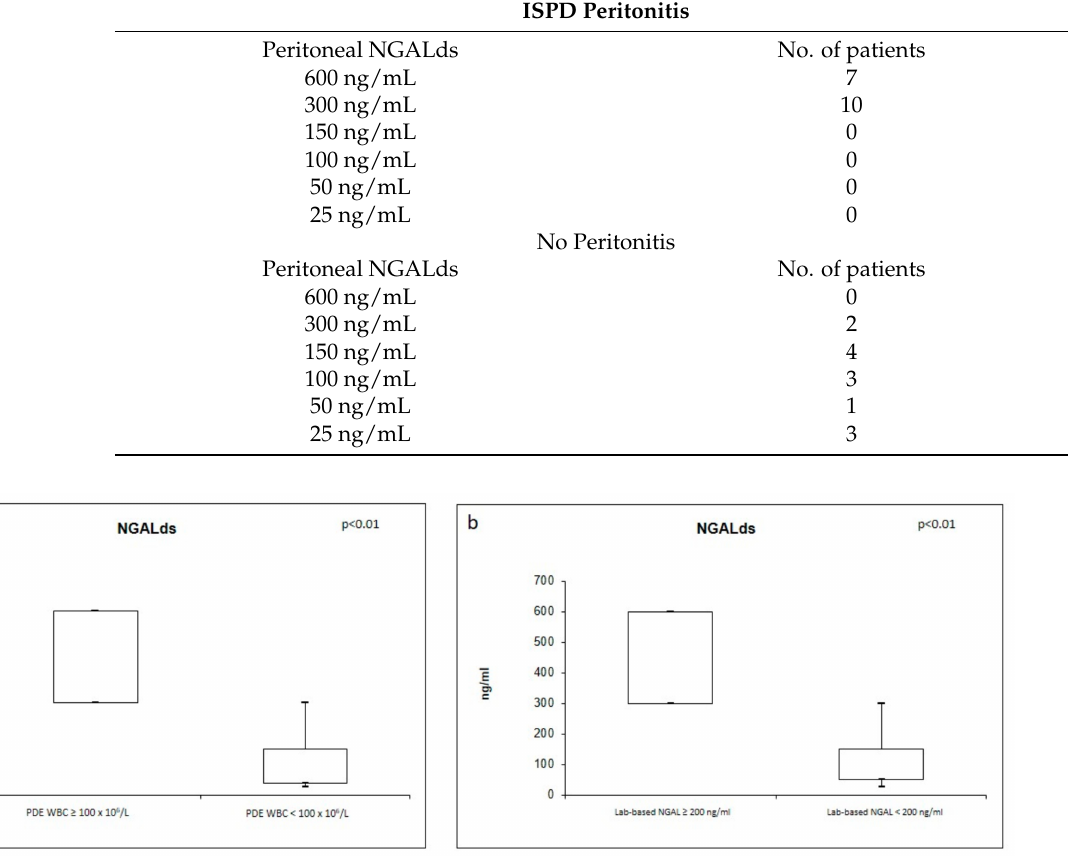
Figure 1. ( a ) Peritoneal NGALds values (n = 30, total number of patients enrolled in the study) in PD patients divided by peritoneal white cell count. Seventeen PD patients have peritoneal white cell count ≥ 100 × 10 6 /L and thirteen PD patients have peritoneal white cell count ≥ 100 × 10 6 /L, ( b ) peritoneal NGALds values (n = 30, total number of patients enrolled in the study) in PD patients divided by peritoneal laboratory-based NGAL. Seventeen 17 PD patients have peritoneal laboratory- based NGAL ≥ 200